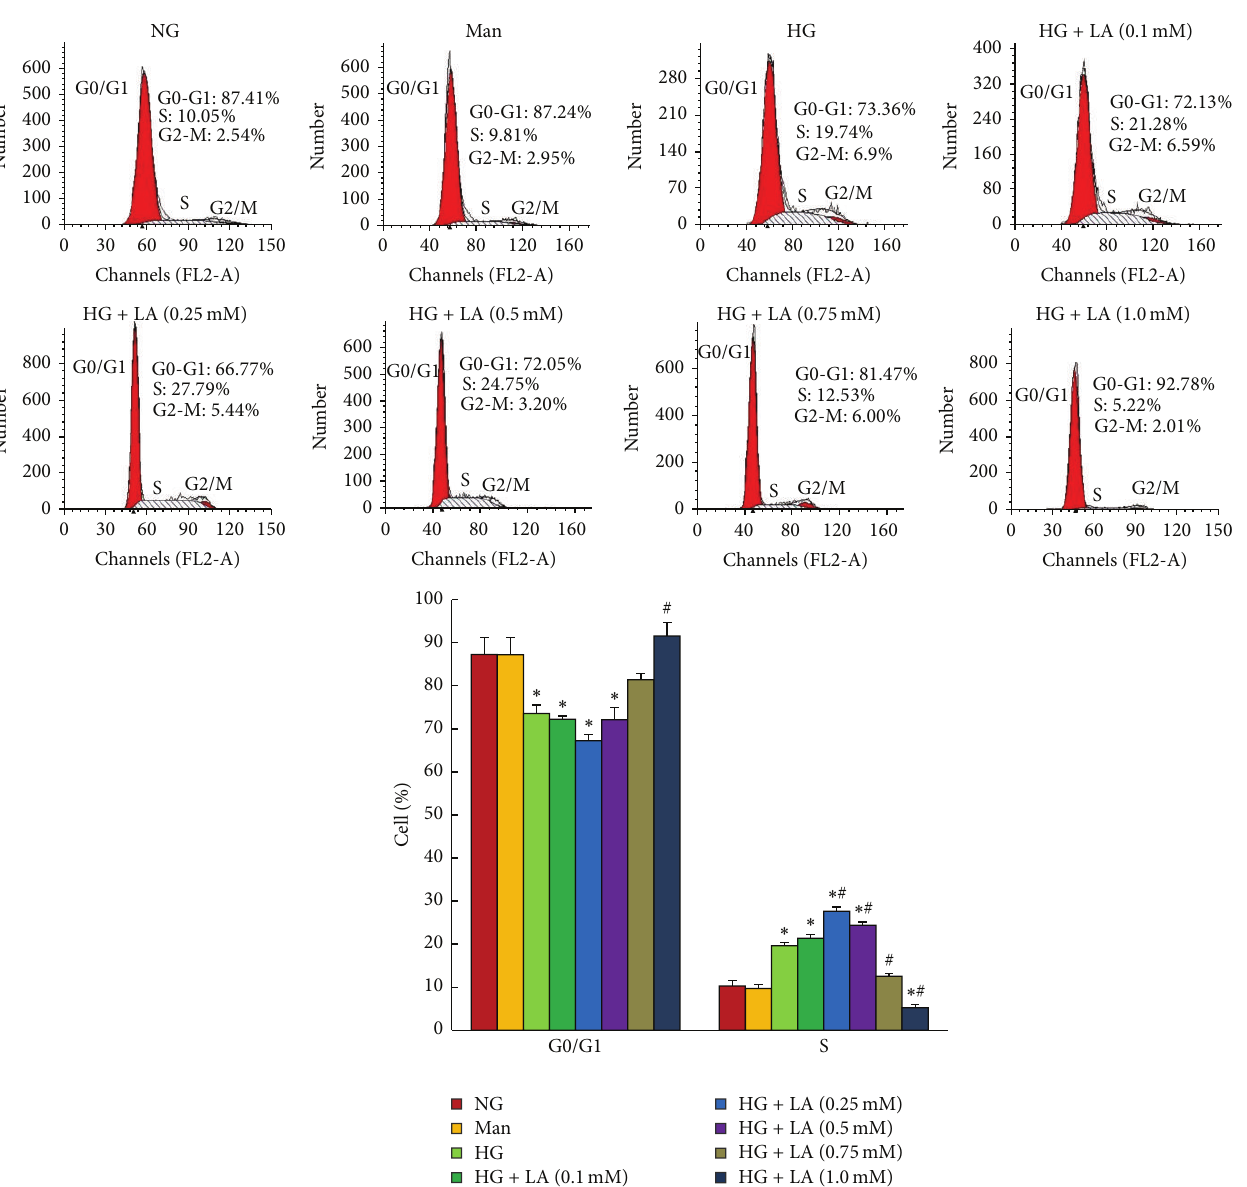
Figure 2: LA concentration-dependently modulated mesangial cell-cycle progression stimulated by high glucose. MCs were preincubated in medium with high glucose for 1h and then stimulated with various concentrations of LA for 24 h, respectively. LA with final concentrations of 0.1 and 0.25 mM promoted cell-cycle progression induced by high glucose, with a maximum promotion at 0.25 mM, while cell cycle was inhibited as the dose of LA increased above 0.5 mM, with a maximum inhibition at 1 mM. Cells were analyzed by flow cytometry after PI staining and the relative percentage of cells in different cell-cycle phases is reported, while the percentage of apoptotic events was ignored. Data in the bar graphs represent the mean ± SD ( 𝑛 = 3 ). 𝑃 < 0.05 was considered statistically significant. Note: ∗ 𝑃 < 0.05 versus NG; # 𝑃 < 0.05 versus HG. Abbreviations: NG, normal glucose (5 mM); Man (5 mM glucose + 25 mM mannitol); HG, high glucose